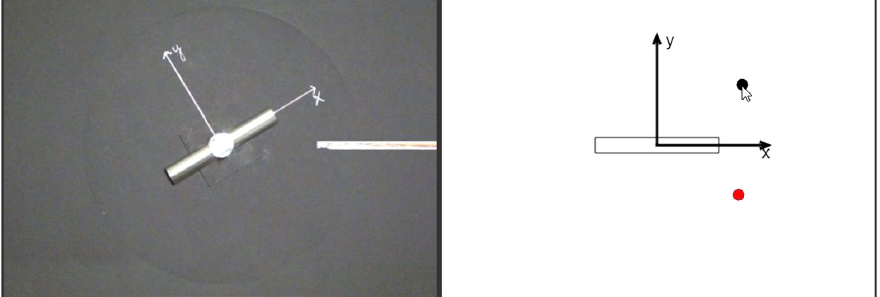
FIG. 5. Screenshot of the first training task in the interactive group. After clicking on the diagram, the clicked position is marked in black and the correct position appears in red.